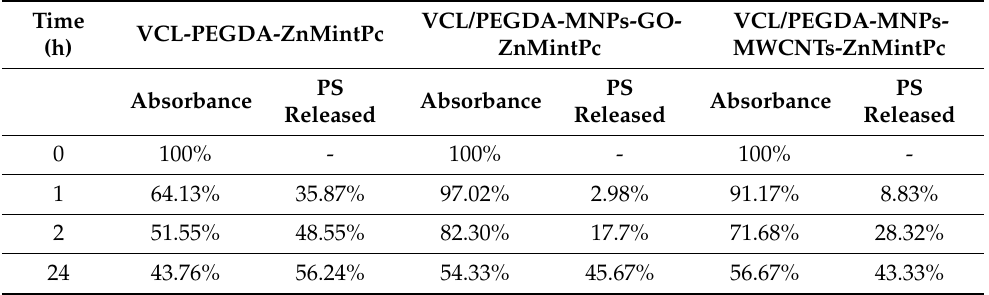
Table 2. Decay of ZnMintPc in nanocomposites in 24 h.